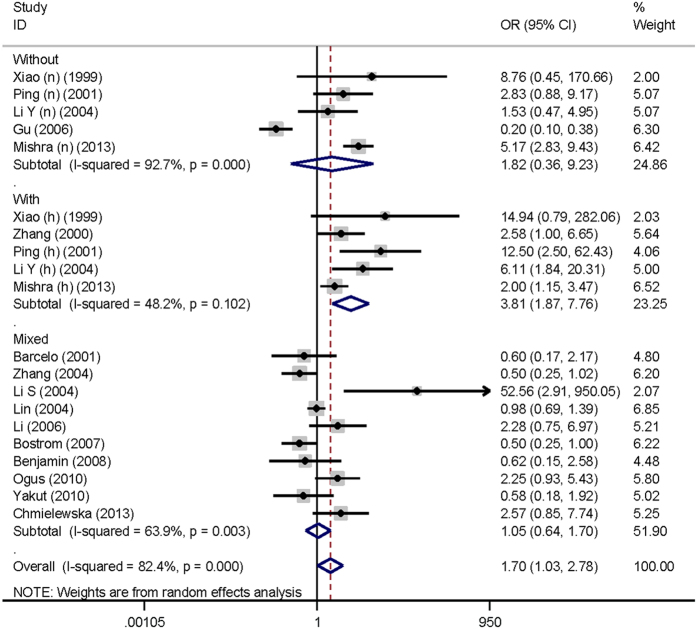
Forest plot of OSAS susceptibility conferred by the comparison of ACE gene II genotype with DD genotype by hypertension status.